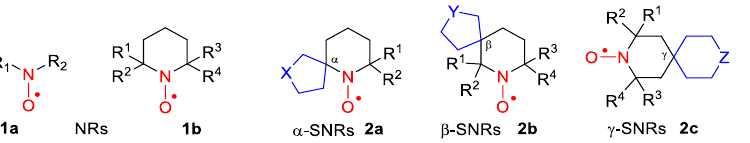
Figure 1. Structures of cyclic nitroxyl radicals (NRs) and -, -, and -spirocyclic nitroxides (SNRs).